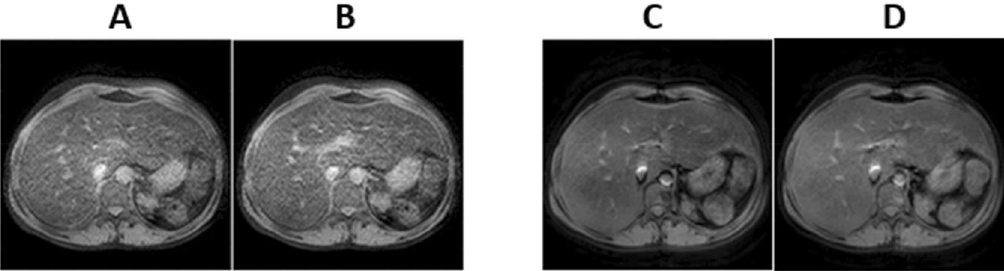
Figure 5. MRI images of the same patient using: ( A ) standard T2*, ( B ) optimised T2*, ( C ) standard T2 and ( D ) optimised T2 sequences.